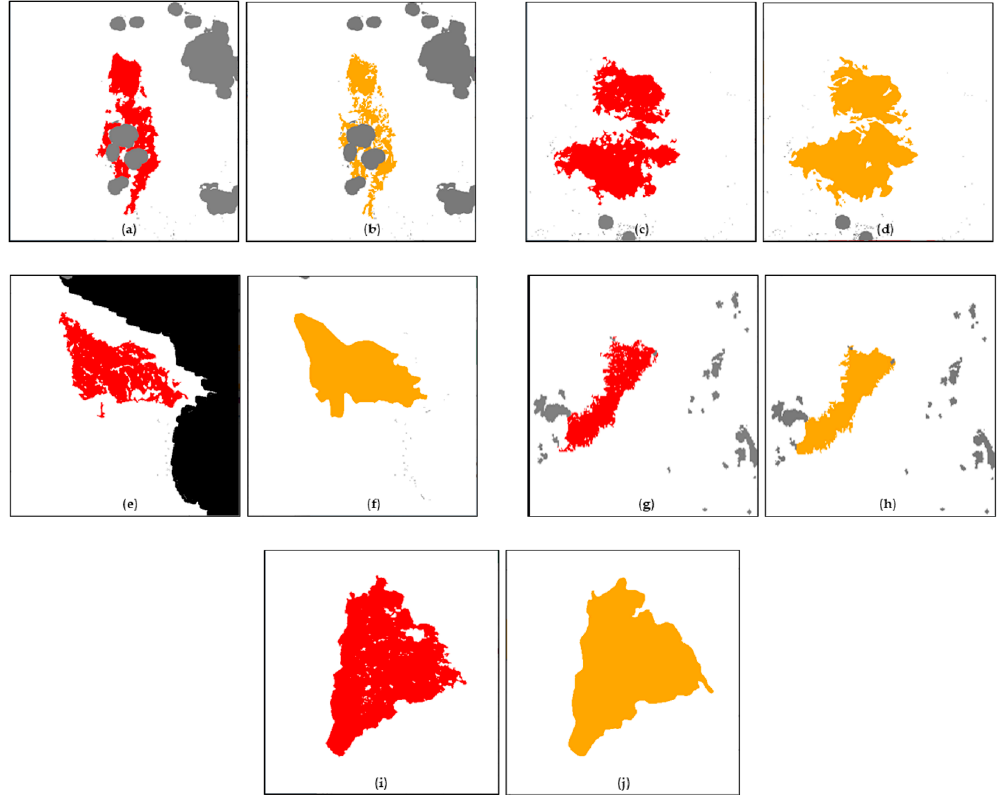
Figure 9. Maps of burned areas derived from AUTOBAM and Copernicus Emergency Management Service (CEMS); ( a ) AUTOBAM-derived map for the Evia Island event (EMSR306); ( b ) CEMS-derived map for the Evia Island event (EMSR306); ( c ) AUTOBAM-derived map for the Tuscany event (EMSR316); ( d ) CEMS-derived map for the Tuscany event (EMSR316); ( e ) AUTOBAM-derived map for the Sithonia event (EMSR331); ( f ) CEMS-derived map for the Sithonia event (EMSR331); ( g ) AUTOBAM-derived map for the Mount Kenia event (EMSR345); ( h ) CEMS-derived map for the Mount Kenia event (EMSR345); ( i ) AUTOBAM-derived map for the Castile and Le ó n event (EMSR368); ( j ) CEMS-derived map for the Castile and Le ó n event (EMSR368). Red: BA according to AUTOBAM; orange: BA according to CEMS; white: unburned; black: unclassified (e.g., sea); gray: clouds (enlarged by creating a bu ff er zone, see Section 3.2.1) according to the scene classification (SCL) included in the level 2A (L2A)